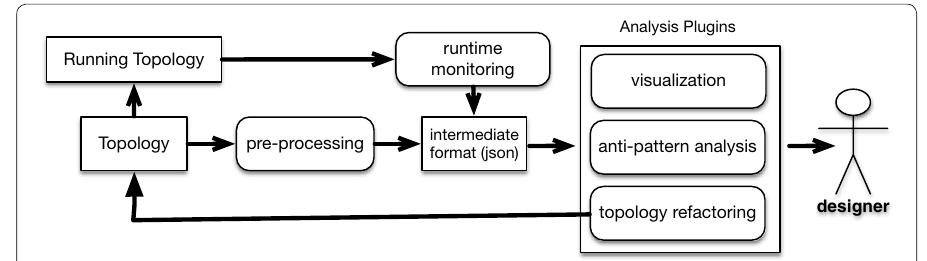
Fig. 1 OSTIA extensible